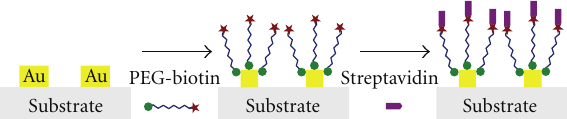
Figure 2: The principle of biological sensing with metamaterial gold